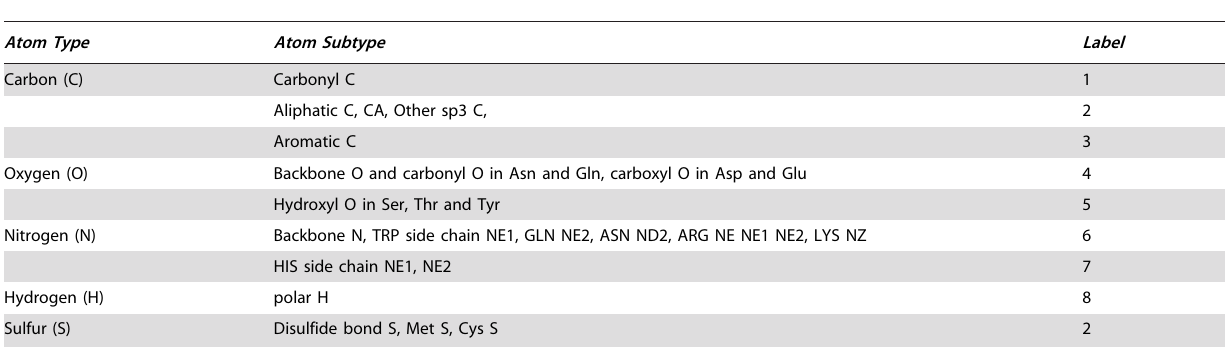
Table 1. Atom types used in binding site